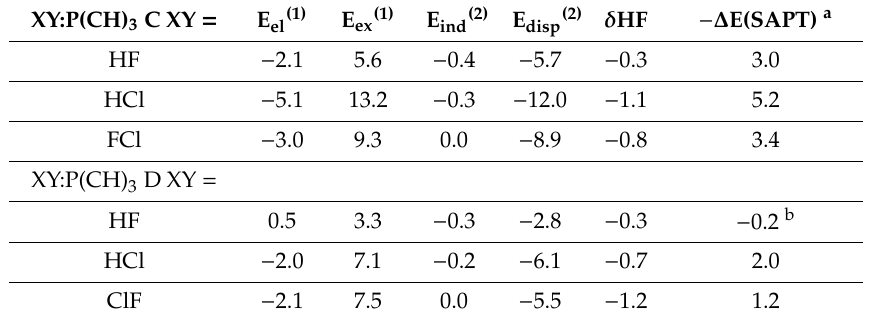
Table 6. SAPT energies (kJ mol − 1 ) for equilibrium XY:P(CH) 3 complexes isomers C and D